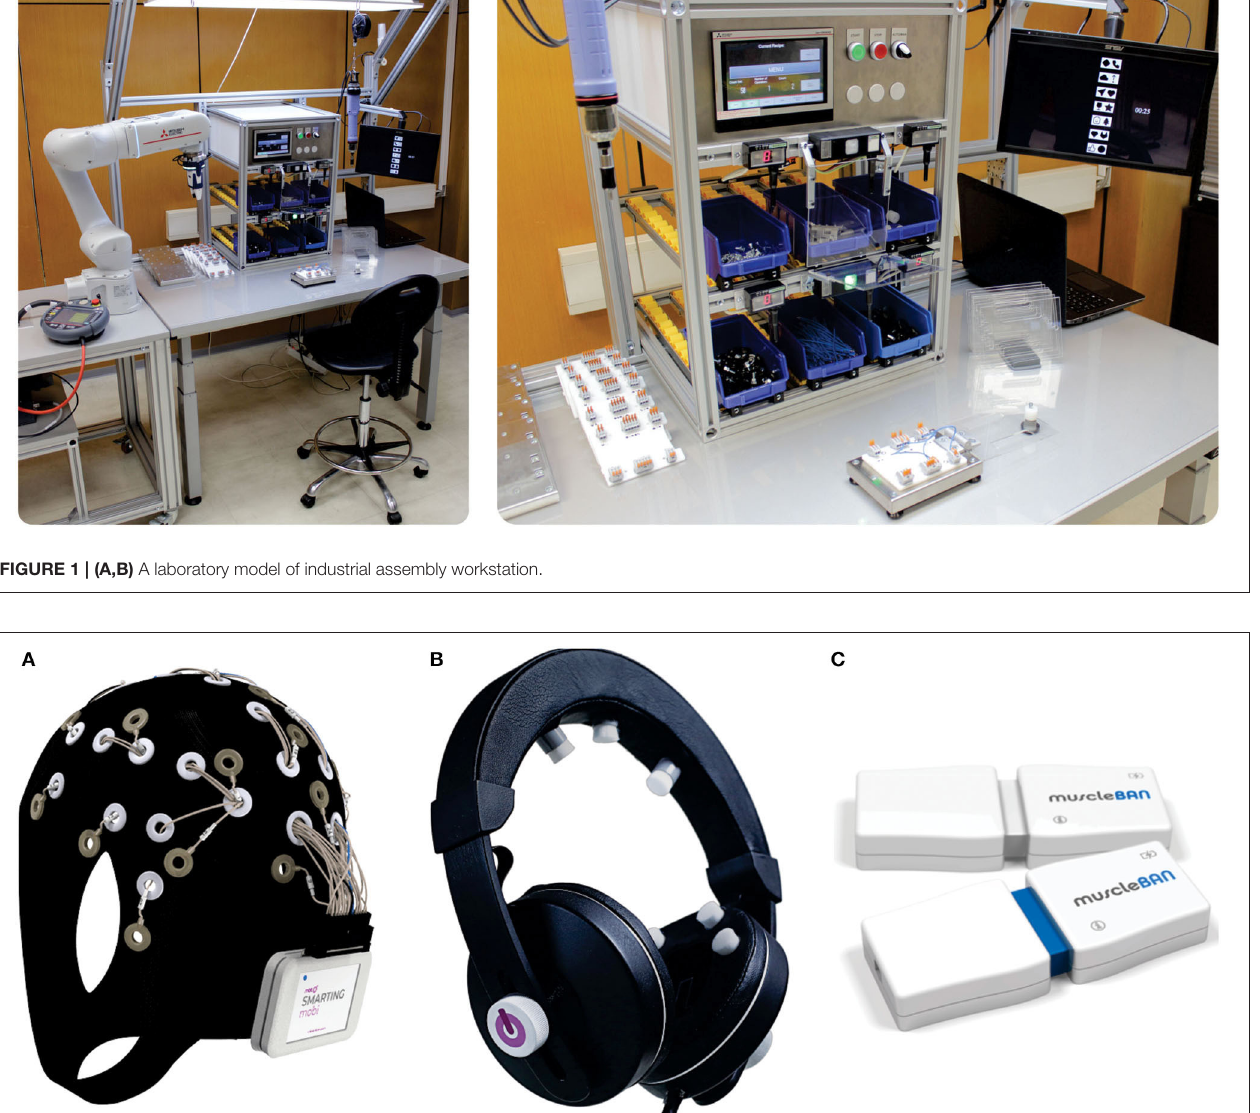
FIGURE 2 | (A) EEG Cap, (B) EEG Smartfones, (C) EMG